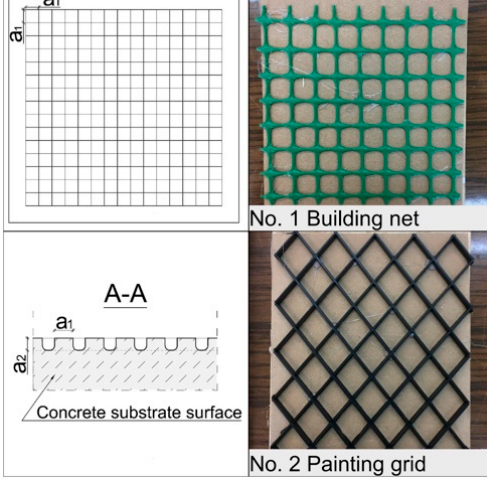
Figure 1. The applied grooving method for texturing the surface of the concrete substrate (dimensions: a 1 = 8, 10 mm; a 2 = 1.0, 8 mm).